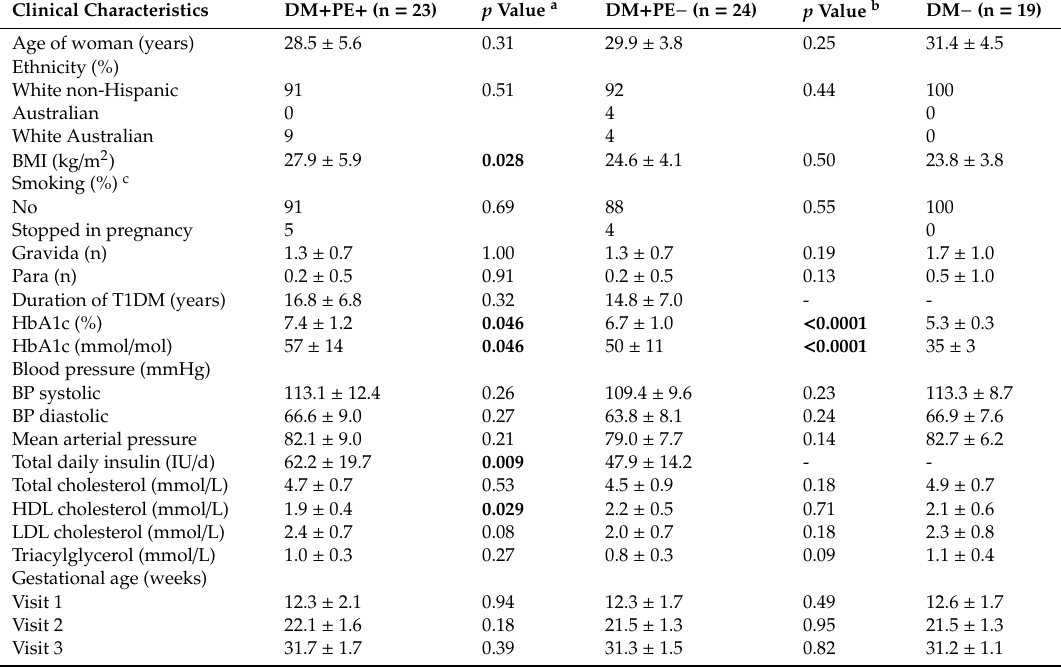
Table 1. Clinical characteristics, at study entry, of women with type 1 diabetes, with and without PE, and normotensive non-diabetic